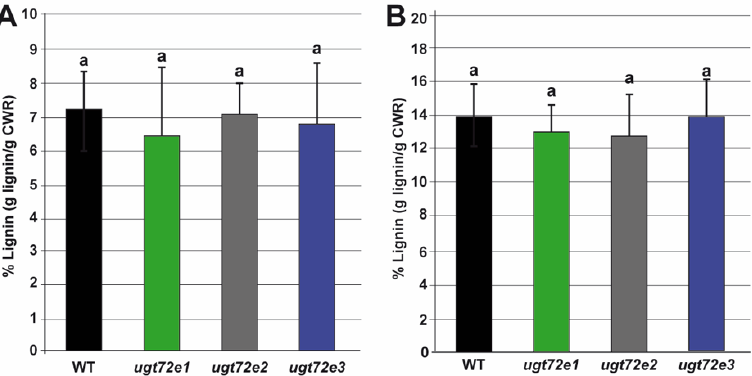
Figure 3. Comparison of floral stem lignin content in WT and ugt72e mutants. The lignin dosage was performed by the acetyl bromide method in the young ( A ) parts ( n = 5 replicates each containing 8 fragments) and old ( B ) parts ( n = 5 replicates; each containing 4 fragments) of the floral stems. Values are expressed as mean values ( ± SD). No significant di ff erences were shown by a Kruskal–Wallis test. CWR = cell wall residue.